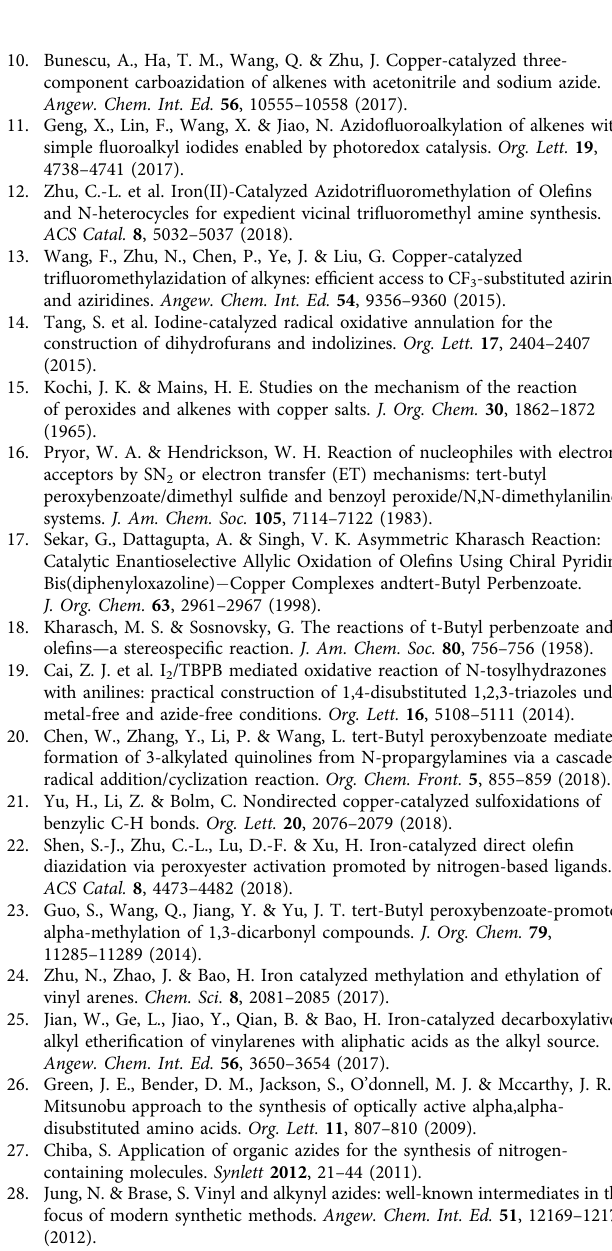
Fig. 8 Further synthetic transformations. a Synthesis of 1,2,3-triazoles. b Synthesis of